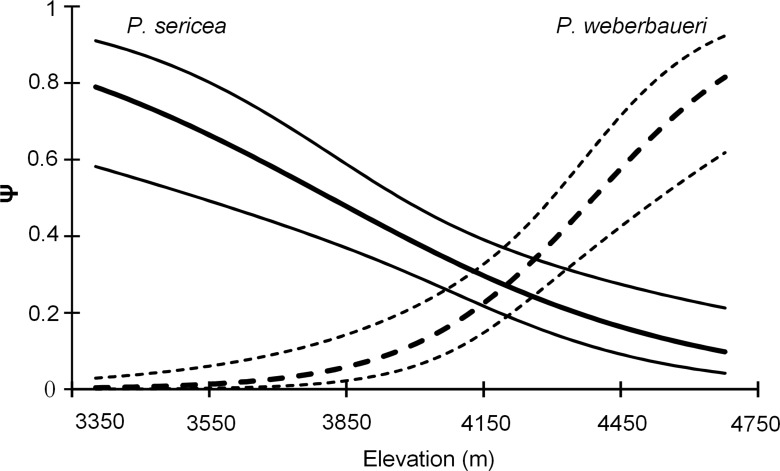
Occupancy estimates ψ for P. sericea and P. weberbaueri along an elevational gradient. Fine lines represent the 95% CI.